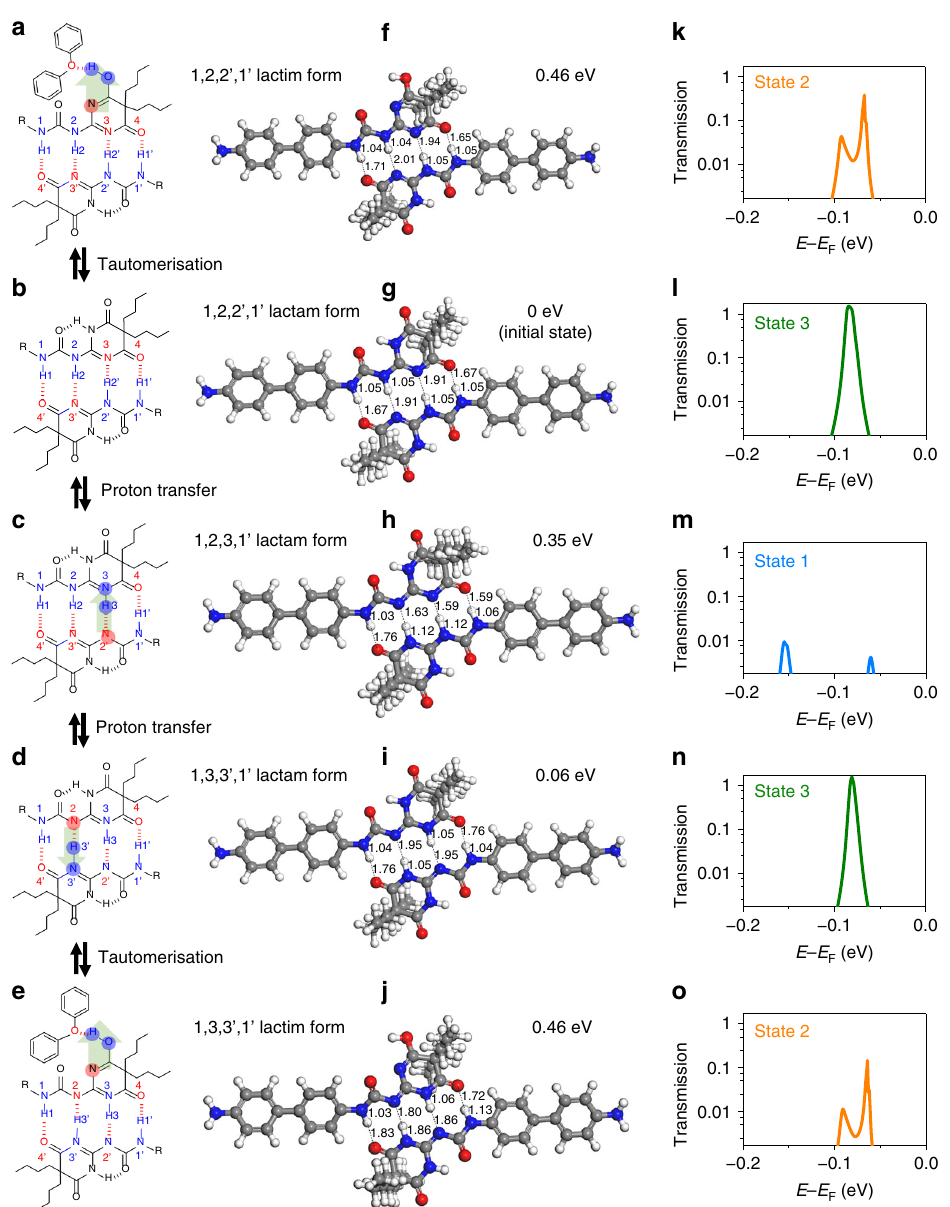
Fig. 5 Theoretical model of hydrogen bond transformations. Schematic diagram of each transformation process ( a – e ) with fi ve low-lying energy structures ( f – j ) and corresponding transmission spectra at a zero bias voltage ( k – o